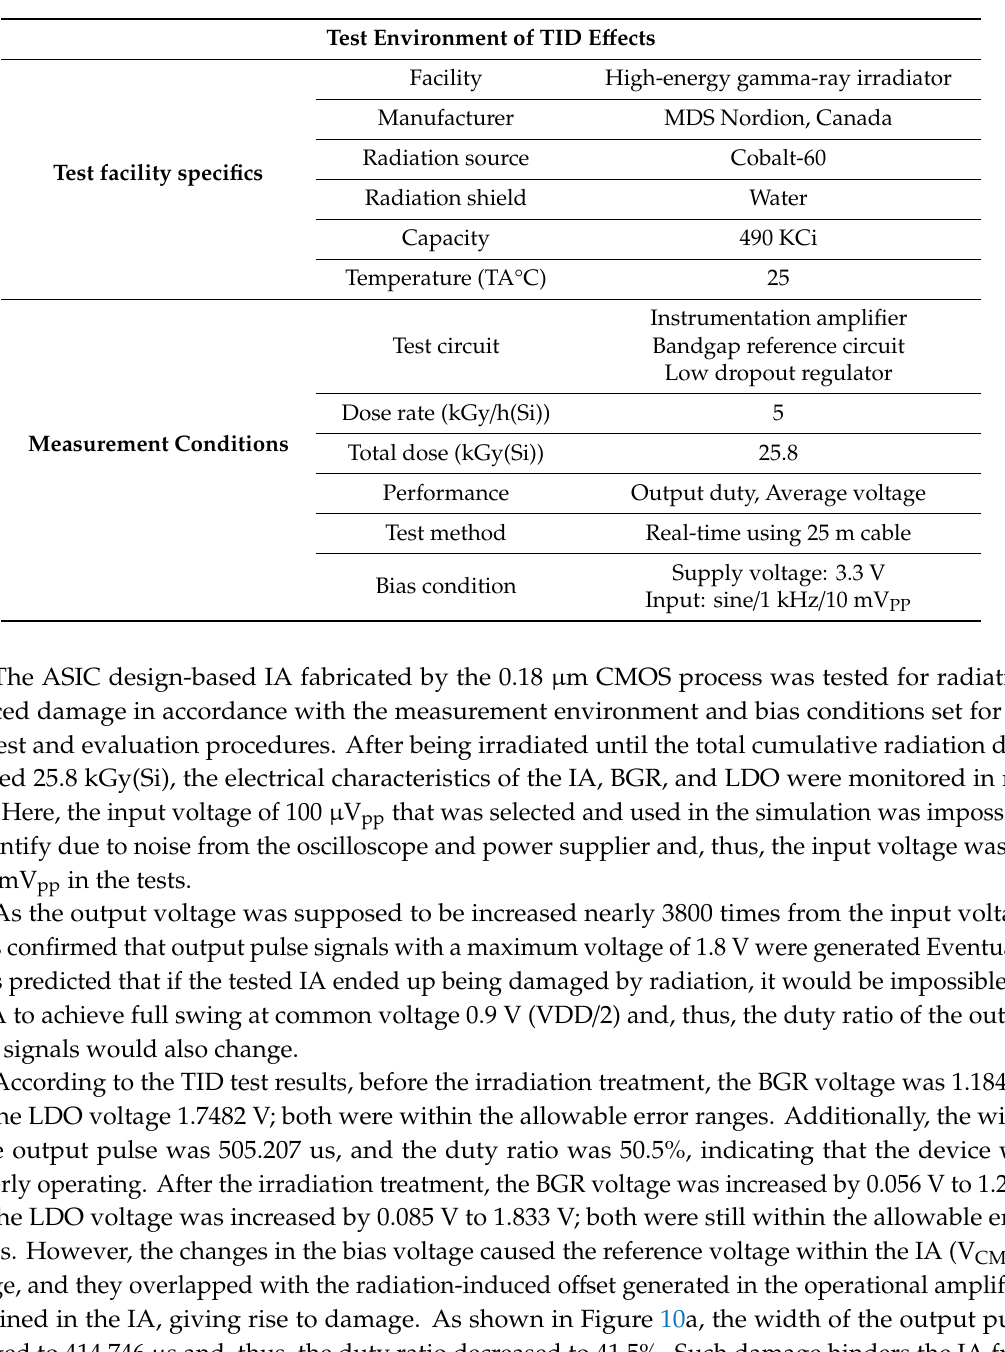
Table 4. Summary of the TID test and evaluation environment for IA